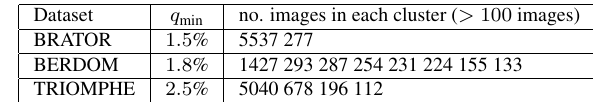
Figure 5. Representive images which are not part of the largest cluster. (a) rotated landmark, (b) Tour de France (c) and (d) rooftop view.